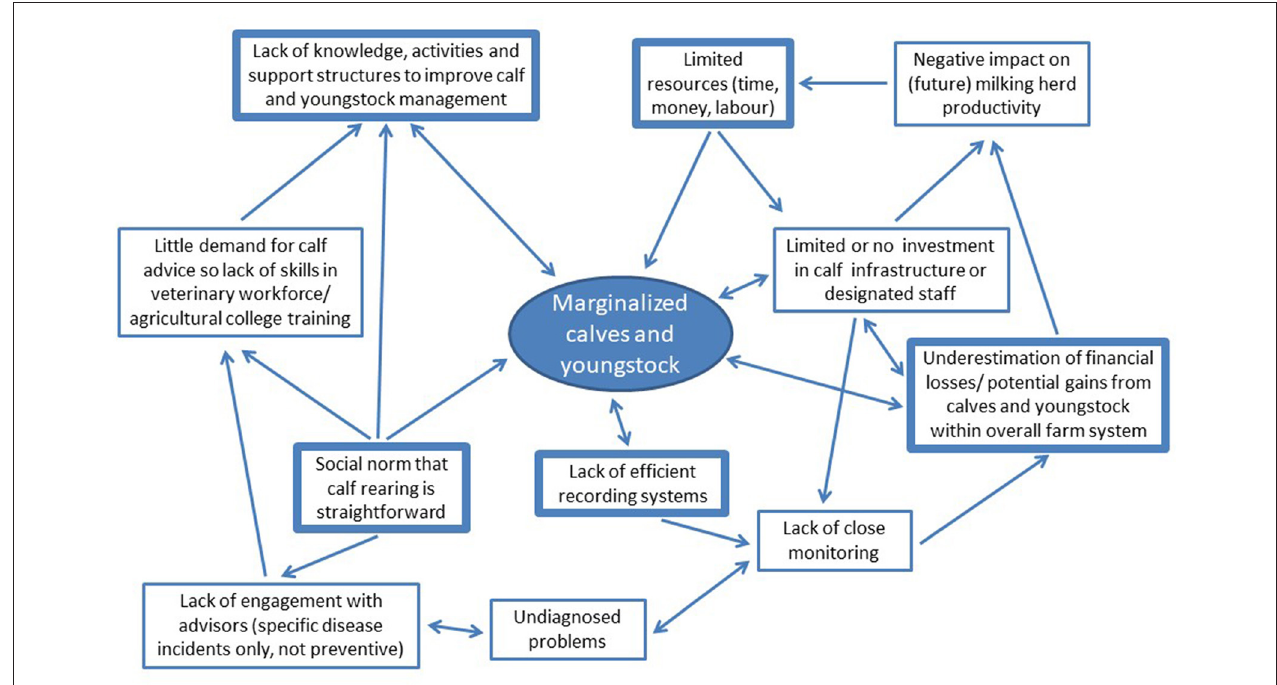
FIGURE 1 | Schematic demonstrating the effect of marginalisation of replacement heifer calves. Limited resources, unrecognised potential of calves, lack of data monitoring, social norms, and scarcity of support structures are key areas for improvement.